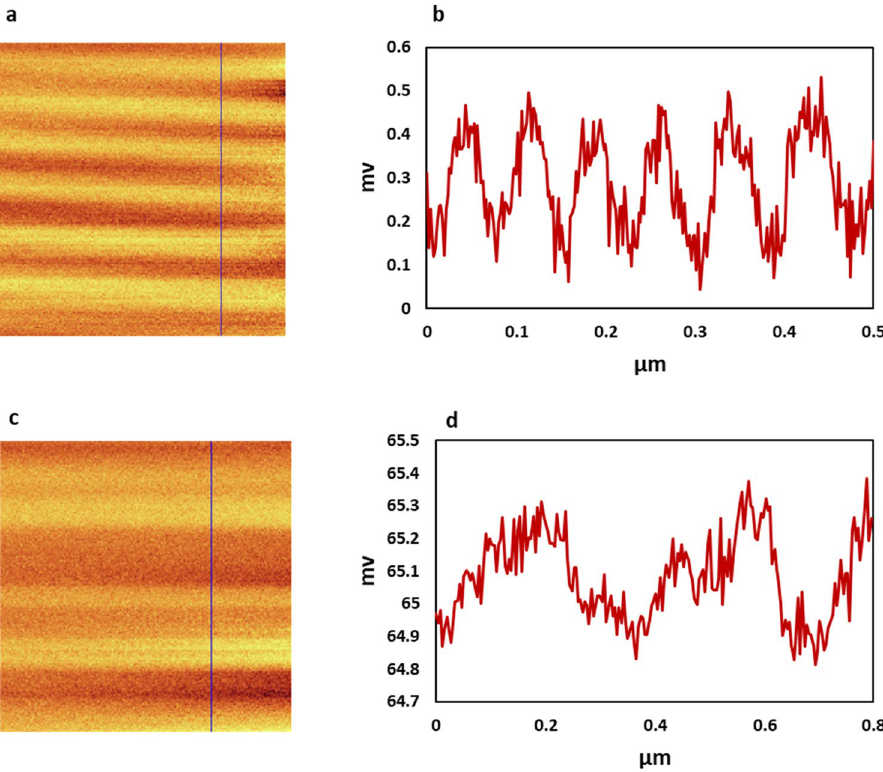
Figure 4. Magnetic domains of LFE- and Autoclave-samples and their domain size. Amplitude images and profile of blue line ( a,b ) LFE-method. ( c,d ) Autoclave-method.